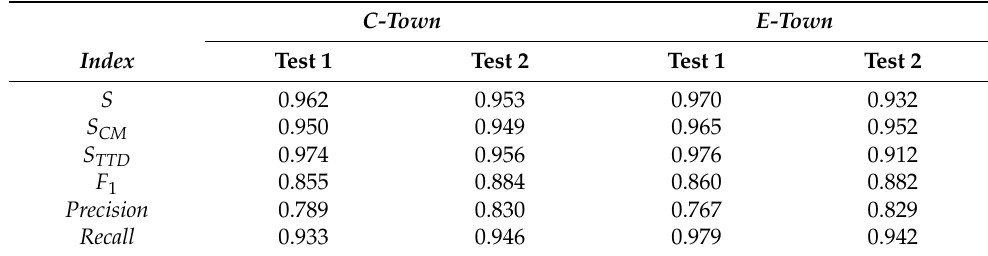
Figure 7. SSDS detection performance; alarms in gray, true events in dashed line; C-Town, Test 1 ( a ), Test 2 ( b ). Table 2. Performances of the SSDS on the test sets in the two case studies.